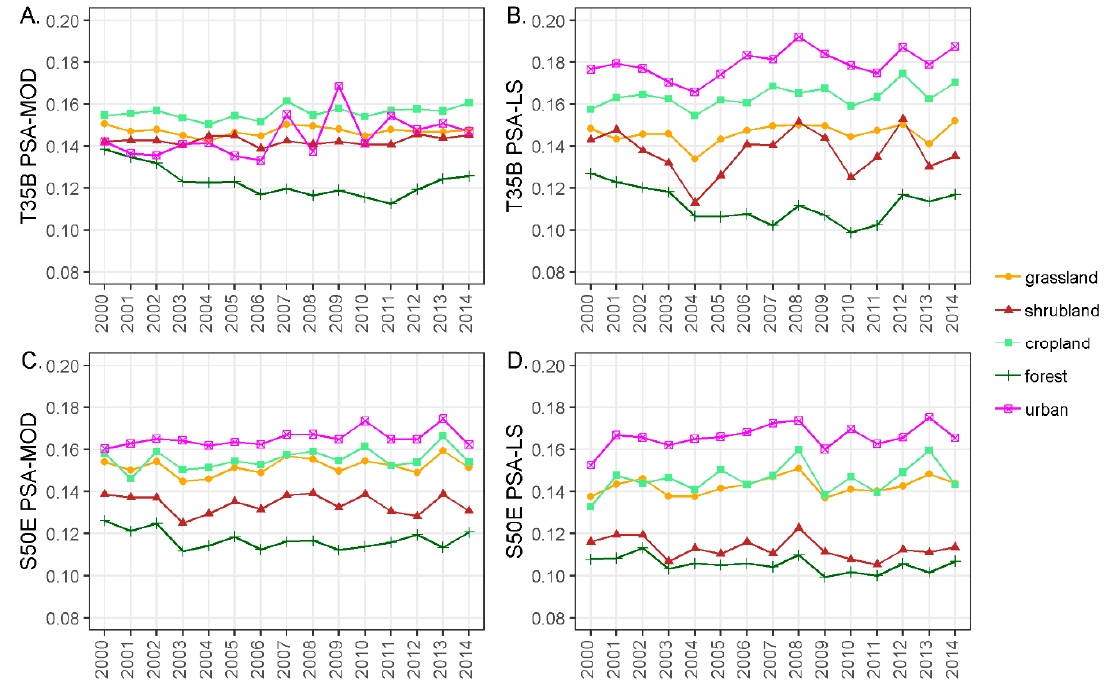
Figure 6. PSA in persistent land cover classes over the study period.